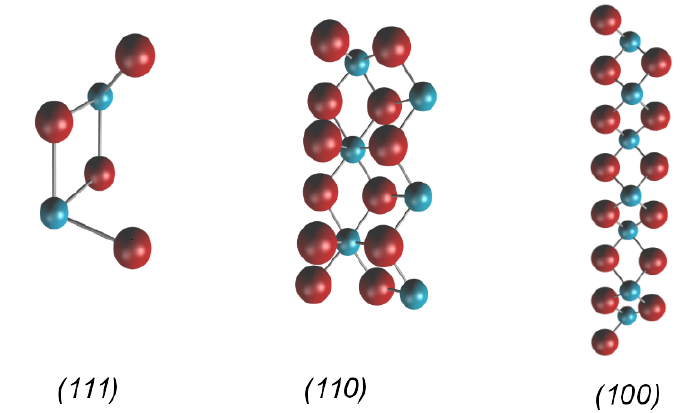
Figure 1. Primitive unit cells of relaxed symmetric slabs of CaF 2 surfaces. For the (111) surface, six layers are used, for the (110) surface, six layers, each consisting of a CaF 2 -unit, and for the (100), 15 layers are used. Fluorides are drawn in red and calcium in blue.